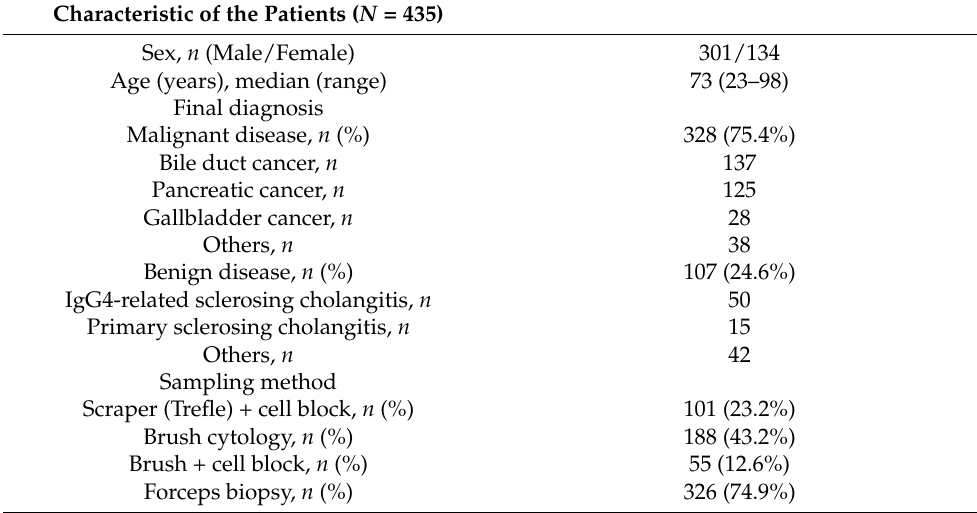
Table 1. Clinical characteristics.